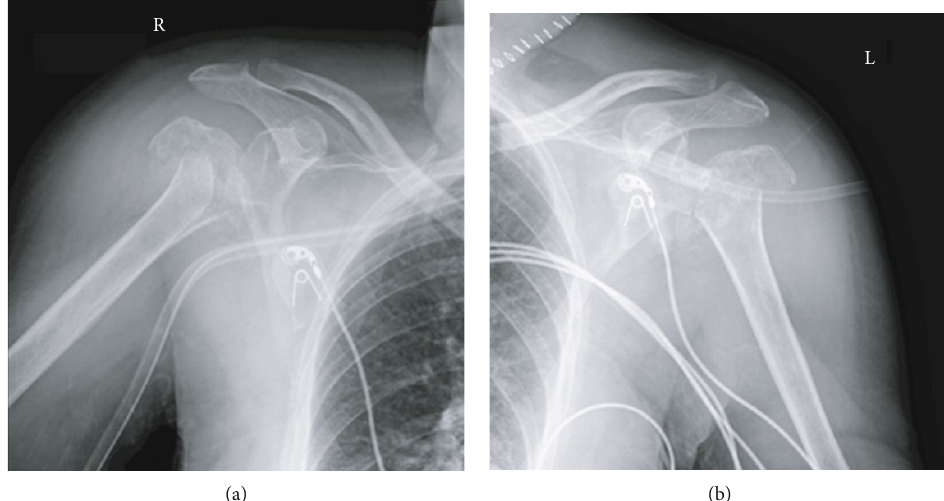
Figure 1: (a) X-ray radiograph of the right shoulder showing a comminuted proximal humerus fracture. (b) X-ray radiograph of the left shoulder showing a comminuted proximal humerus fracture.